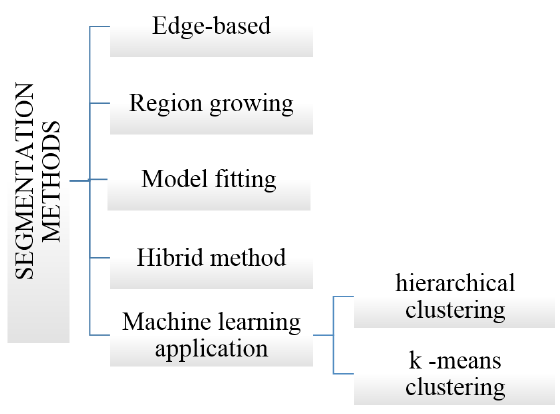
Figure 2: Synthetic representation of the segmentation methods.